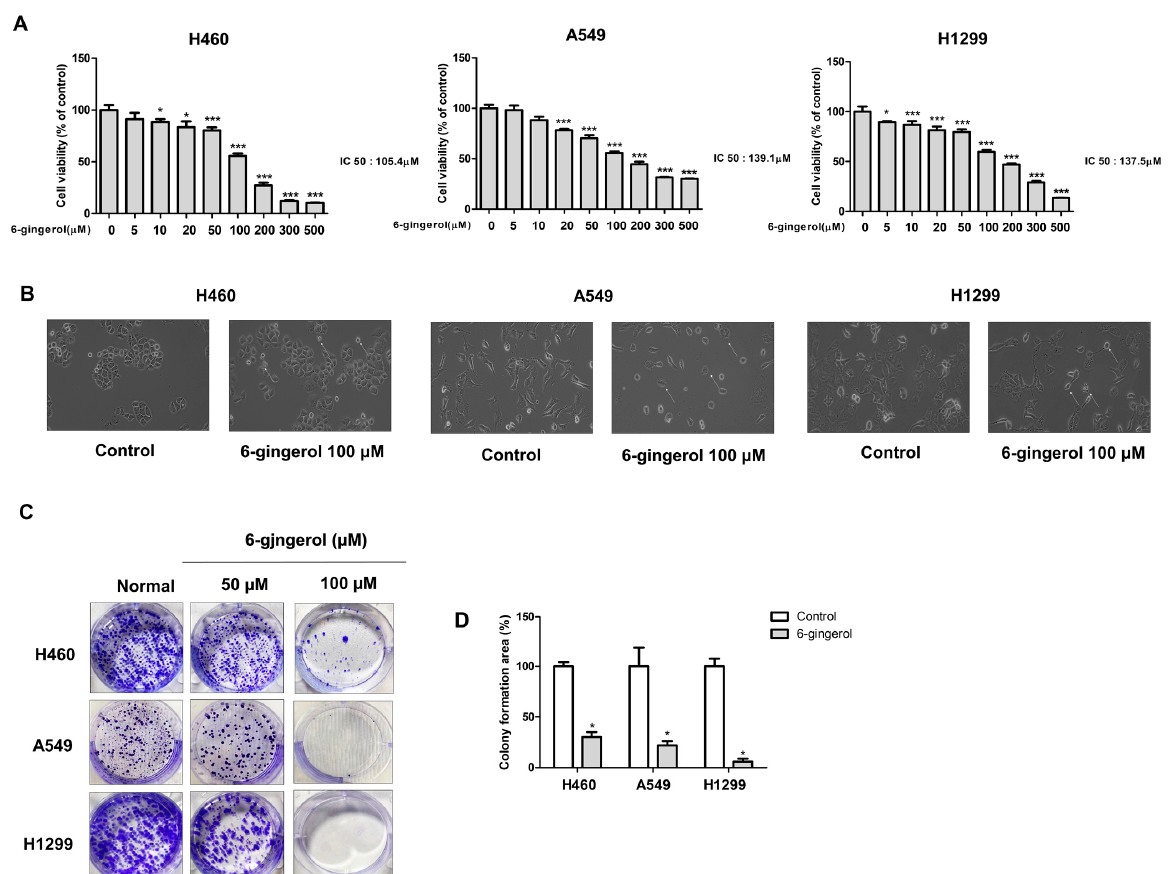
Figure 2. 6-Gingerol treatment suppressed cell growth. ( A ) LC cell lines were treated with different concentrations of 6- gingerol for 24 h. Cell viability was measured by using the MTT assay. ( B ) H460, A549 and H1299 cells were treated with 6-gingerol for 24 h. Cell morphology was observed by phase-contrast microscopy at the original magnification. ( C , D ) H460, A549 and H1299 cells were exposed to 6-gingerol for 7 days. The effect on cell growth was assessed by using a colony formation assay. The data are presented as the mean ± SEM. * p < 0.05, and *** p < 0.001 compared to untreated